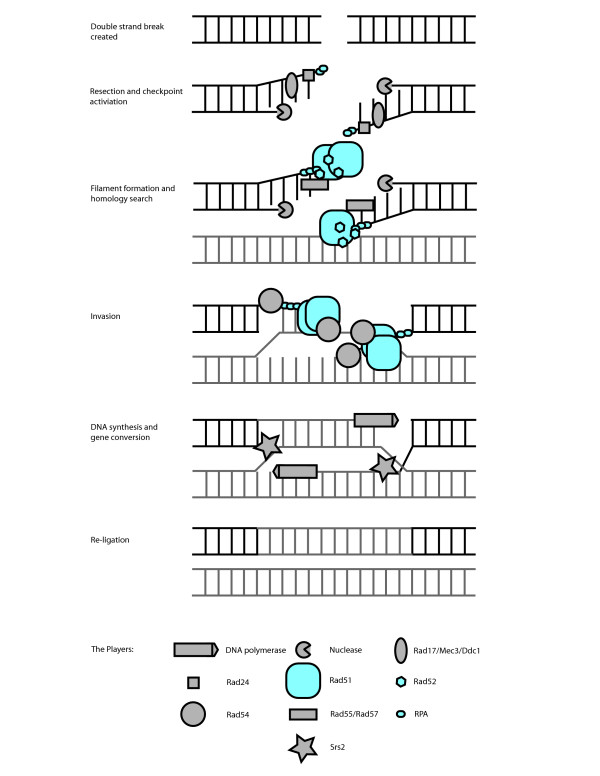
The homologous recombination repair pathway. (See text for explanation.) Blue proteins are present in E. cuniculi; all others are absent. Newly synthesized DNA is indicated in grey. Although the MRX complex (Mre11/Rad50/Xrs2) acts in damage recognition in this pathway, it is not shown. (Modified from Aylon and Kupiec [24].)